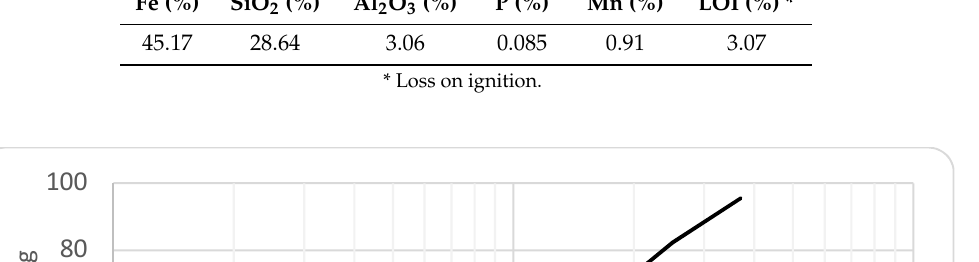
Table 4. Chemical analyses of the iron ore slime (sample 1).